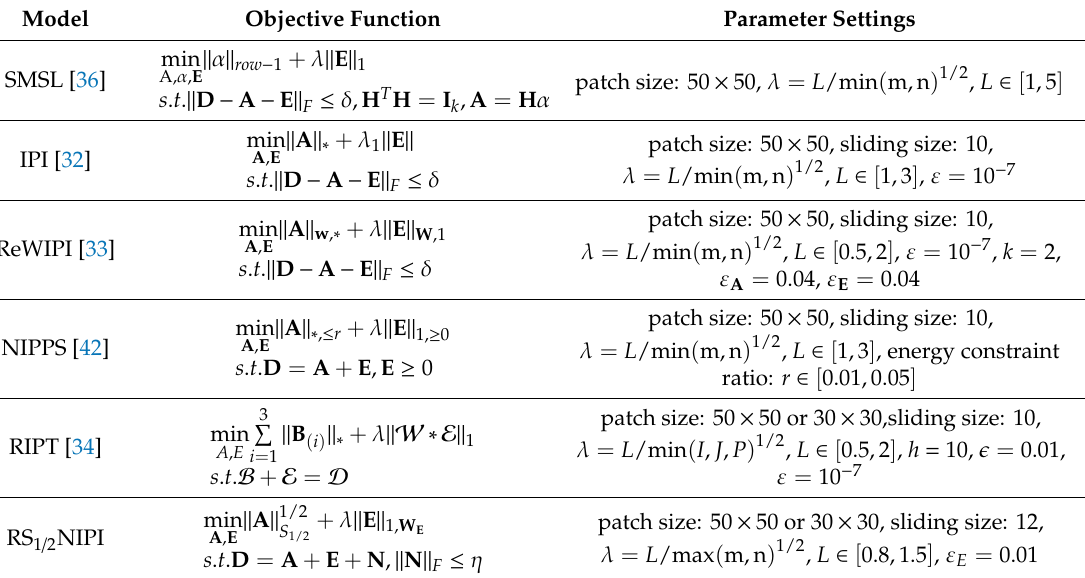
Table 2. Objective functions and detailed parameter settings for the low-rank recovering methods. Model Objective